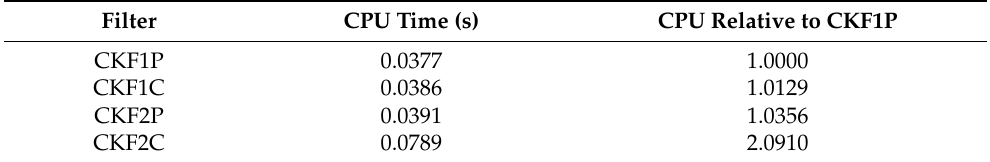
Table 5. CPU times (s) for each Monte Carlo run and CPU times relative to CKF1P for angle SD of 1